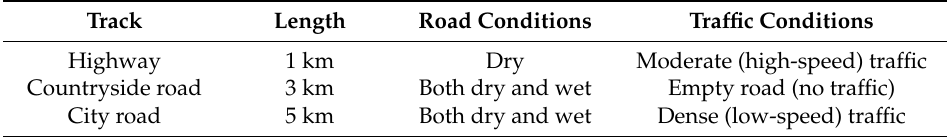
Table 2. Details of the tracks used in experiments on Forum 8 full-scale drive simulator.